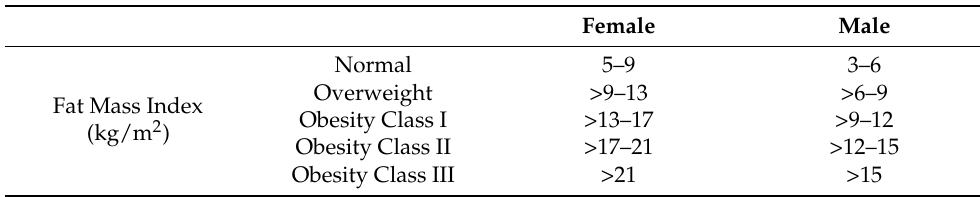
Table 2. Obesity categories according to DXA-based fat mass index obtained from the reference value of the NHANES